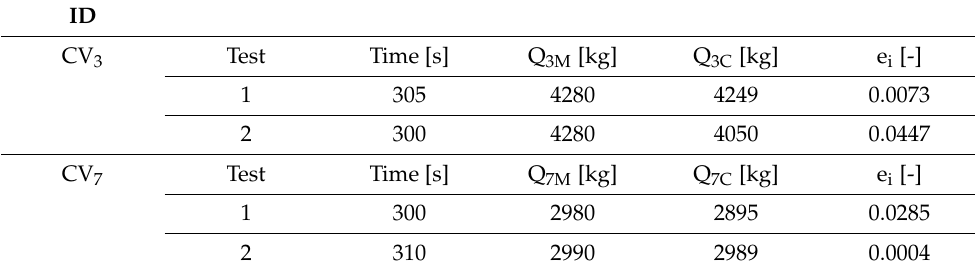
Table 3. Mass measurement for calibration of CV 3 and CV 7